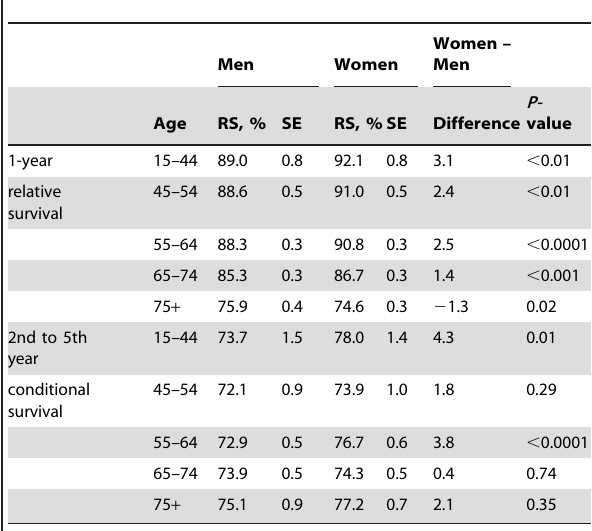
Table 3. Age-specific 1-year relative survival and 5-year relative survival conditional on surviving one year,